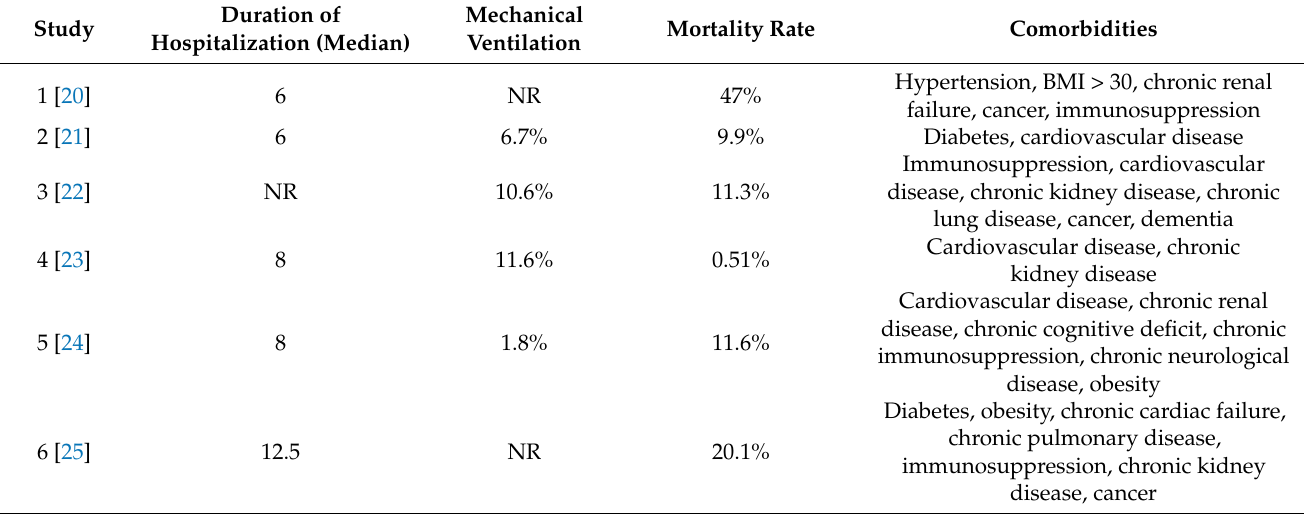
Table 2. Clinical